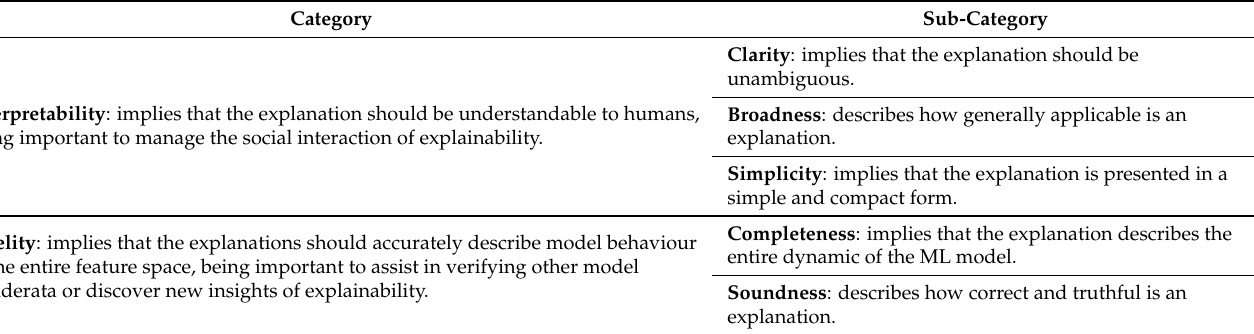
Table 2. Computer-centred evaluation methods: categories and